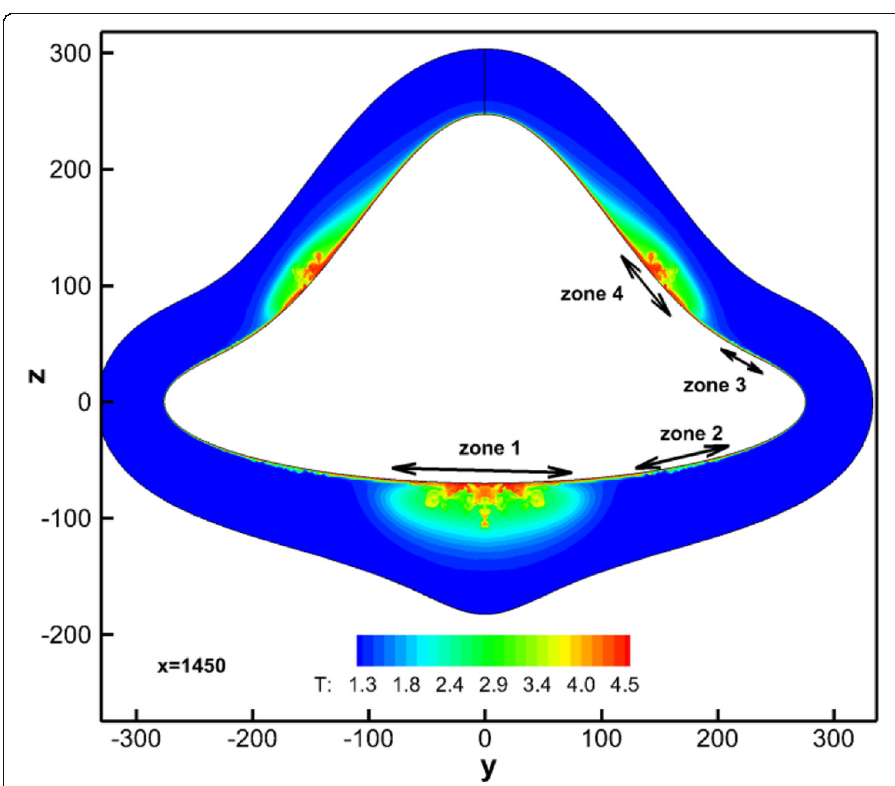
Fig. 11 Contour of the instantaneous temperature at x = 1450